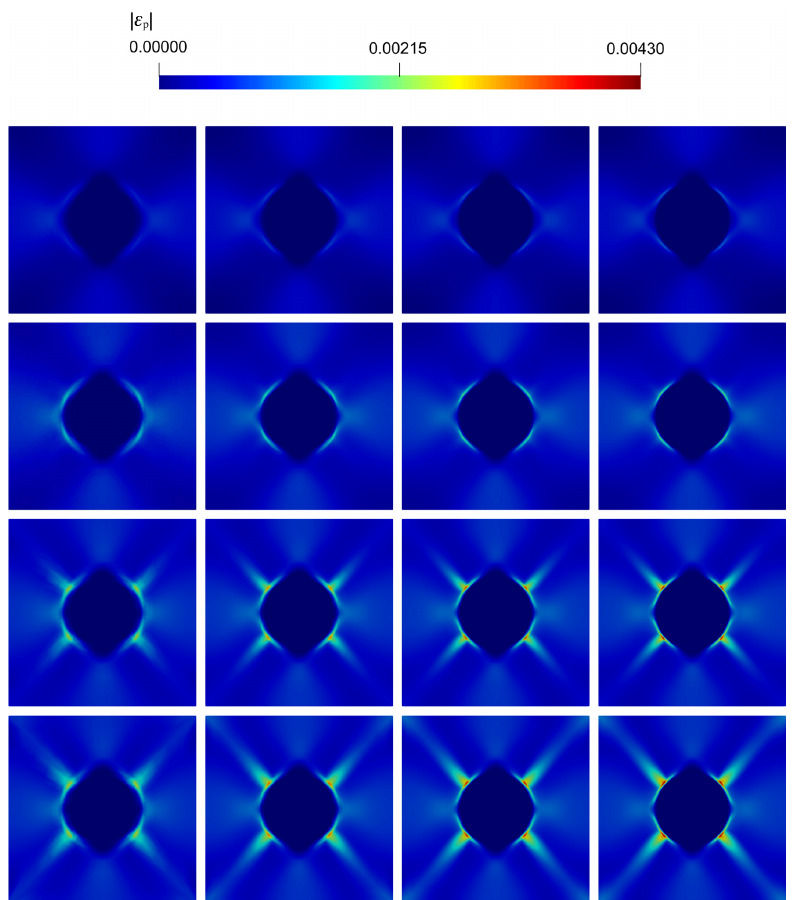
Figure 6: Tension: distribution of plastic strains 𝜀𝜀𝜀 200, 245, 255 and 270